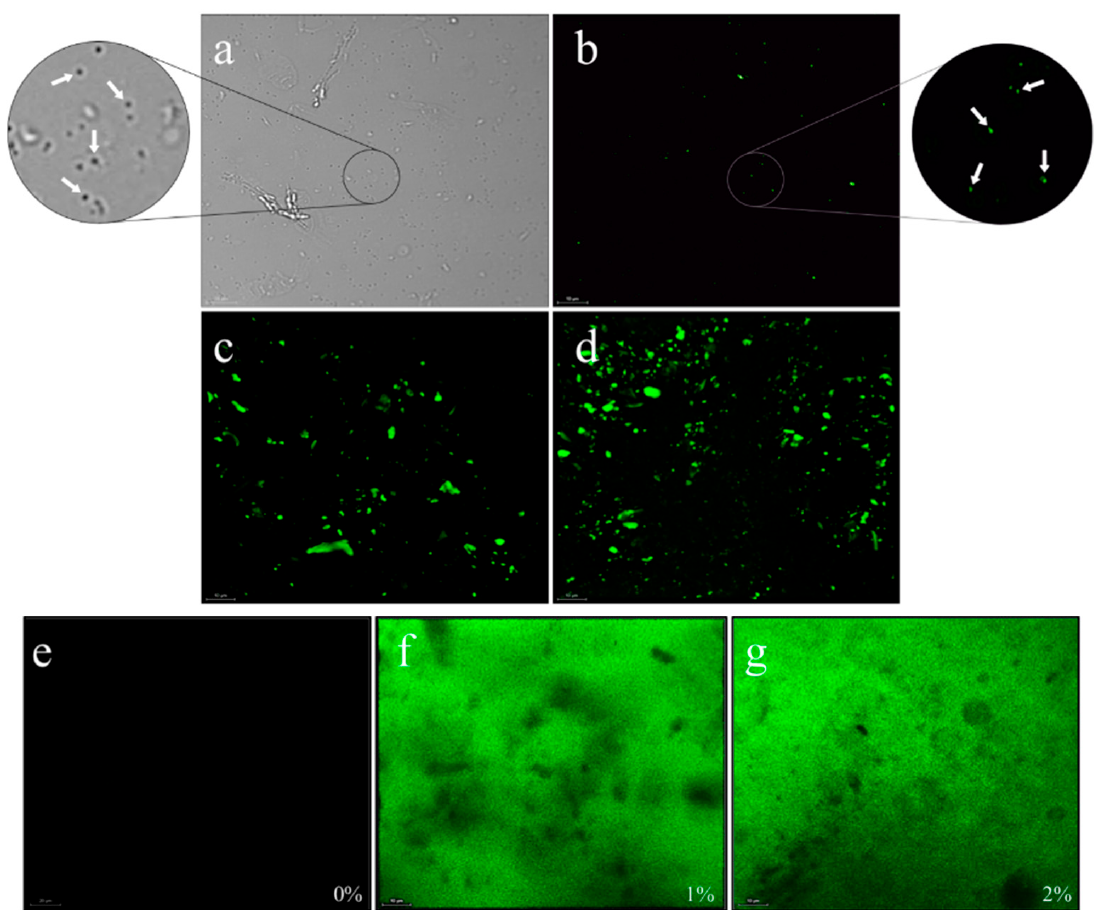
Figure 3. Microstructure of the ( a ) nanoemulsion with 8% Whey Protein Concentrate (WPC), 6% Glycerol (G), and 2% cocoa liquor (CL) diluted 5% in the bright field; ( b ) nanoemulsion with 8% WPC, 6% G, and 2% CL diluted 5%; ( c ) nanoemulsion with 8% WPC, 6% G, and 1% CL; ( d ) nanoemulsion with 8% WPC, 6% G, and 2% CL; ( e ) film with 8% WPC, 6% G without CL; ( f ) film with 8% WPC, 6% G, and 1% CL; and ( g ) film with 8% WPC, 6% G, and 2% CL observed by fluorescence with a Confocal Laser Scanning Microscope (CLSM). White arrows show emulsion droplets from an amplified field fraction. The scale bar represents a length of 10 µ m. The green regions represent the autofluorescence of the cocoa liquor polyphenols.